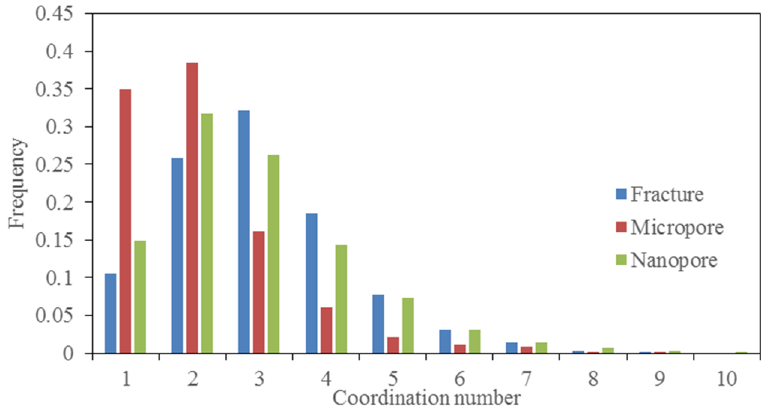
Figure 7. Coordination number distribution.